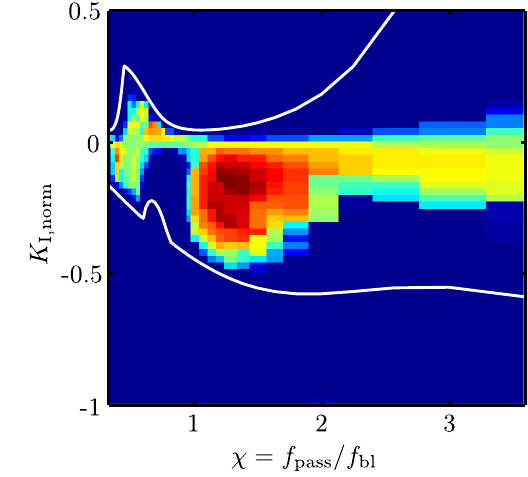
FIG. 11. Amplitude I of the three runs A (open loop), B 1 (bunch length feedback), and C (bunch position and bunch length feedback) of the measurement and the corresponding simulations.